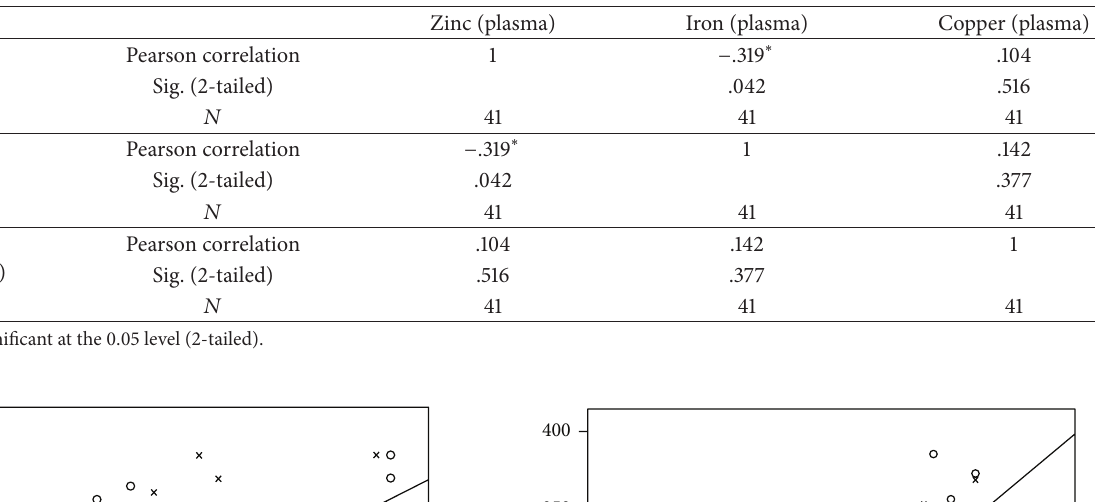
Table 4: Correlation between serum levels of trace elements.